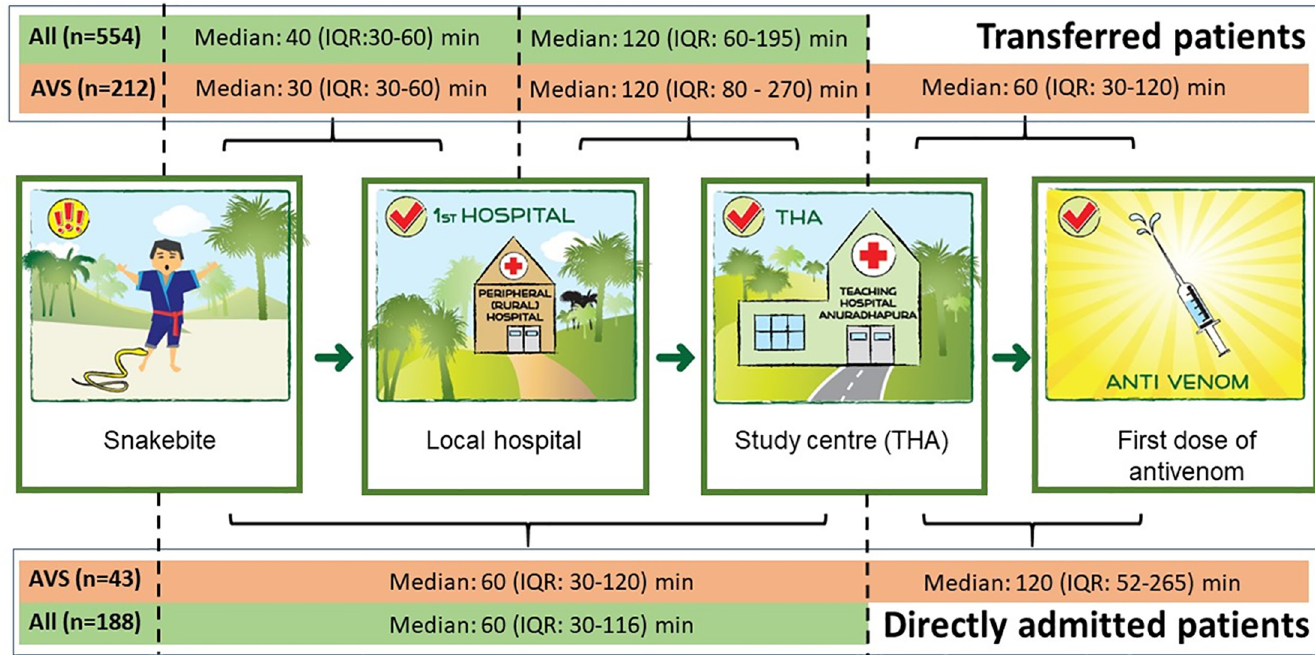
Fig 2. Median times from the bite until the first dose of antivenom at the study hospital, including the different time gaps for transferred patients (n = 534) and directly admitted patients (n = 188).